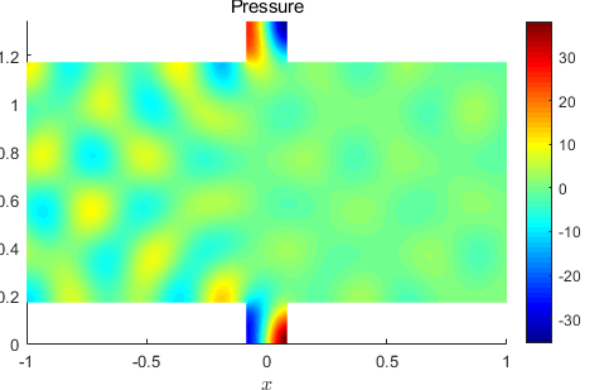
Figure 3. Normalized acoustic pressure distribution around the cavity at the frequency of the embedded trapped mode ( f = 3.187).